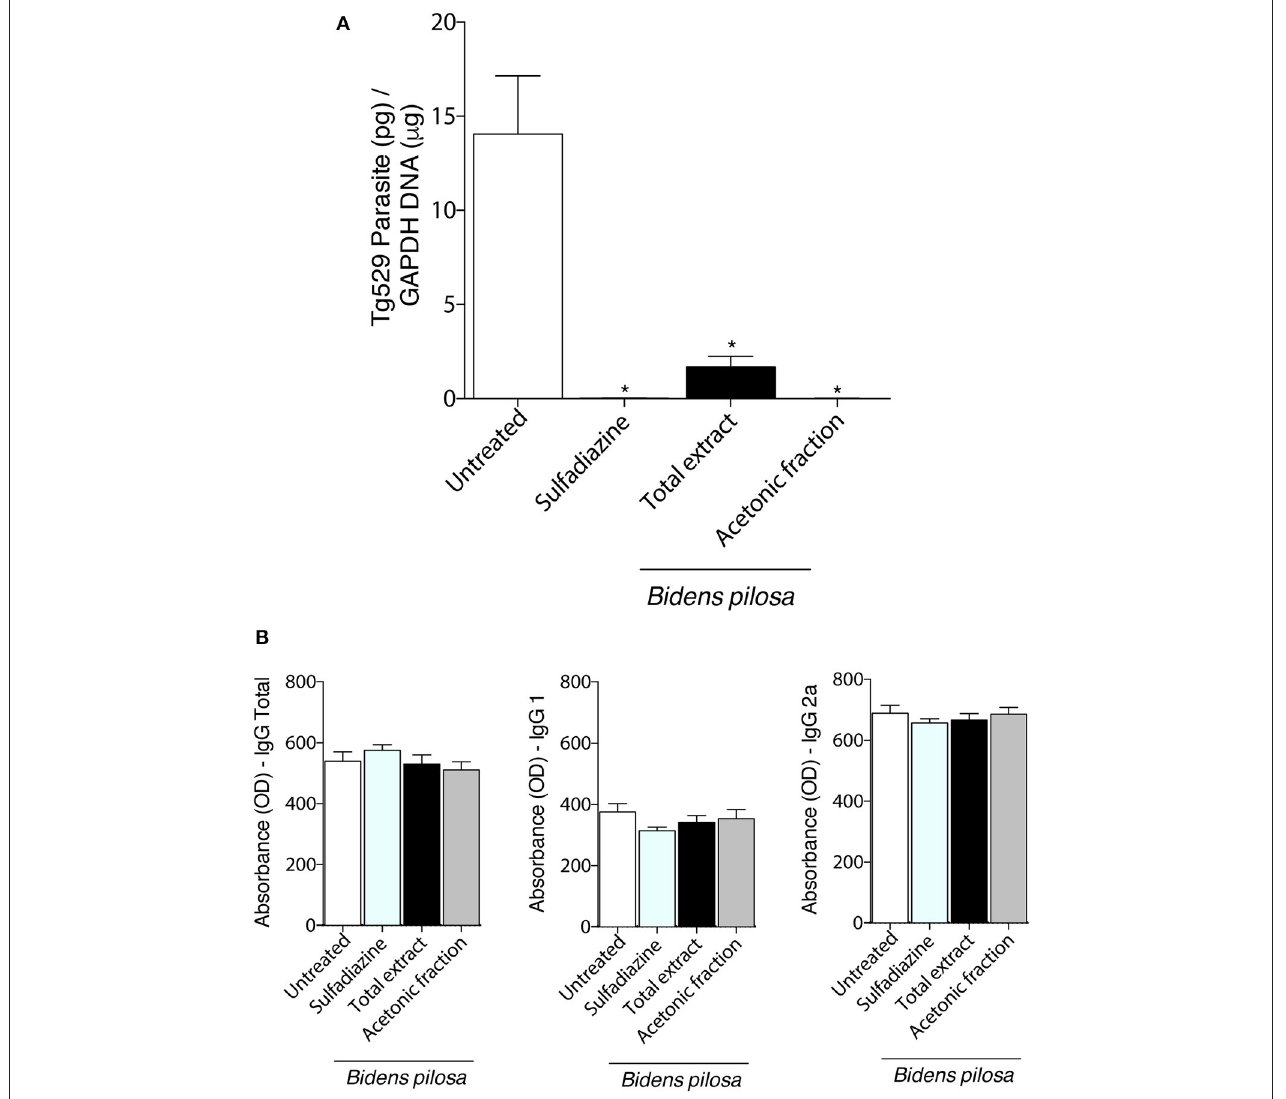
FIGURE 8 | Effects of the treatment with total extract or acetonic fraction of Bidens pilosa in C57BL/6 mice infected for 30 days with Me49 strain Toxoplasma gondii cysts. Four groups of mice (10 animals per group) were infected and treated with total extract or acetonic fraction of Bidens pilosa . As control, mice were treated with PBS only (infection control—Untreated). After treatment, the brain and serum were collected. (A) Brain parasite burden in the four groups determined by qPCR. (B) Comparison between IgG total, IgG1, and IgG2a responses to T. gondii. Values are indicated as mean ± SD of treated mice in relation to untreated ones. *indicate statistically significant differences in comparison with untreated animals (ANOVA and Bonferroni multiple comparison post hoc test; P < 0.05).